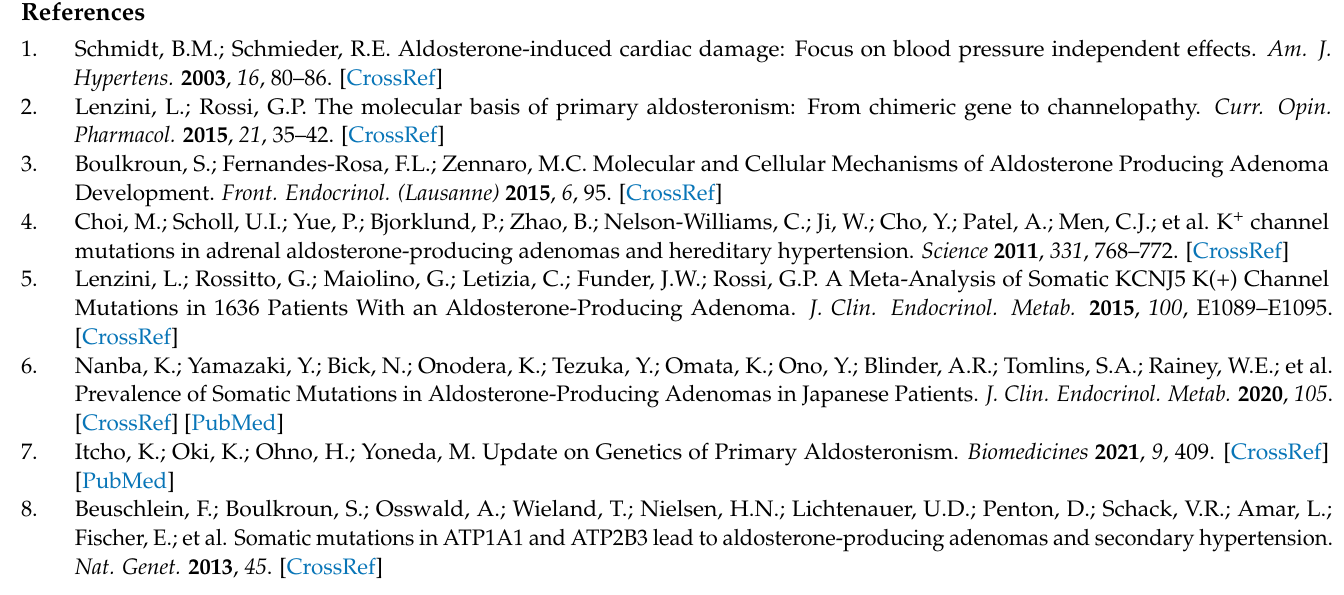
Table S1: Baseline characteristics of the